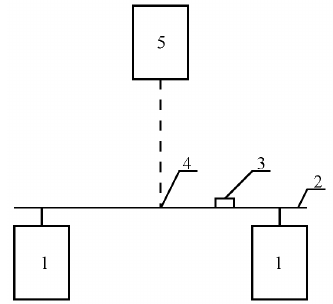
Fig. 3. An experiment scheme of a measurement system graduation of vibrational displacement. Circuit board 2 was placed on vibration exciters 1, where a mechanical contact sensor of vibration acceleration 3 was fixed, and a round white mark 4 with a diameter of 4 mm was plotted on a black background. A recording device, a digital light- optical microscope DigiMicroProf , was placed above this mark. The camera resolution is 5 Mpix. First, the photographing of the mark was carried out in the absence of vibration (Fig. 4a). The resulting photograph was exposed to binarization with a threshold level u l = 0.9 U , and to filtering with the aim to eliminate white inclusions outside the mark image, and black holes inside this image. In line reading of binary filtered image, counting of the number of pixels was carried out belonging to the mark image by (2), as a result of which the area of the round mark image S imt 0 was measured in the absence of vibration. Based on this result, the radius of the mark image was calculated by (5) in the absence of vibration l 0 .